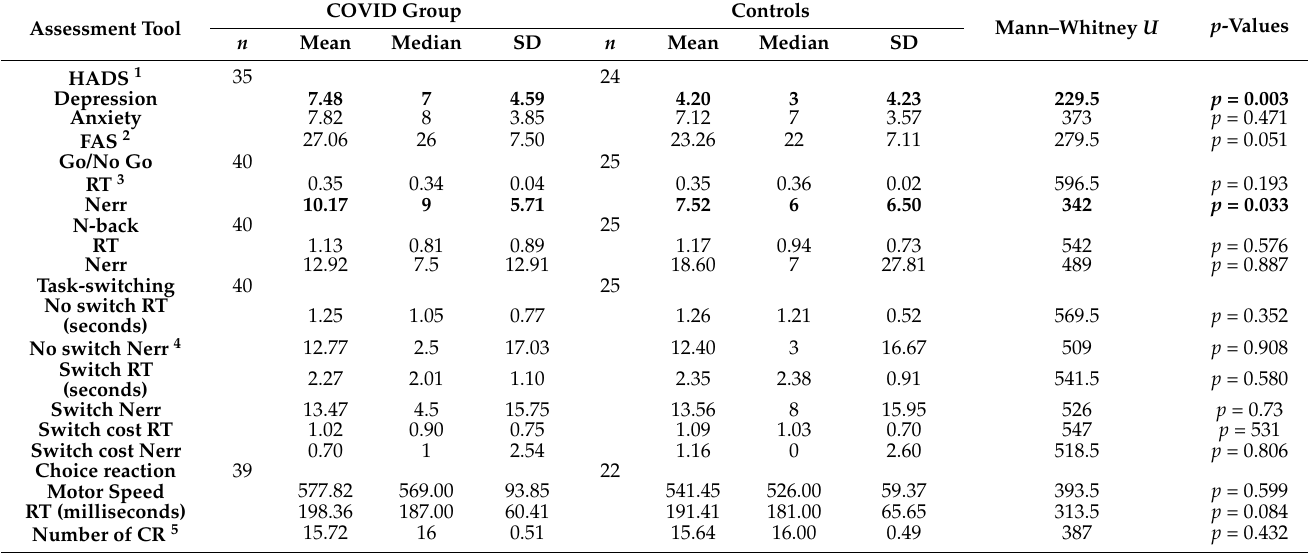
Table 3. Descriptive statistics and Mann–Whitney U test results for two